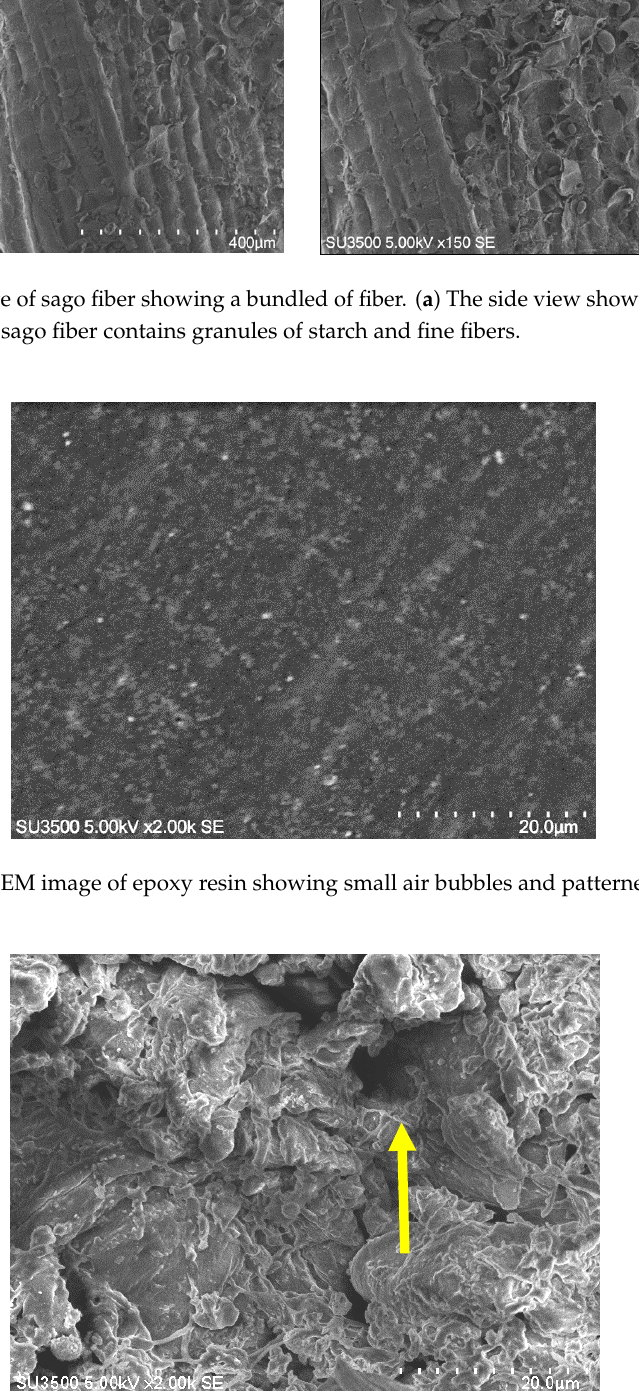
Figure 4. An example of an SEM image of sago fiber composite, taken from sample E9. The yellow arrow shows a void.